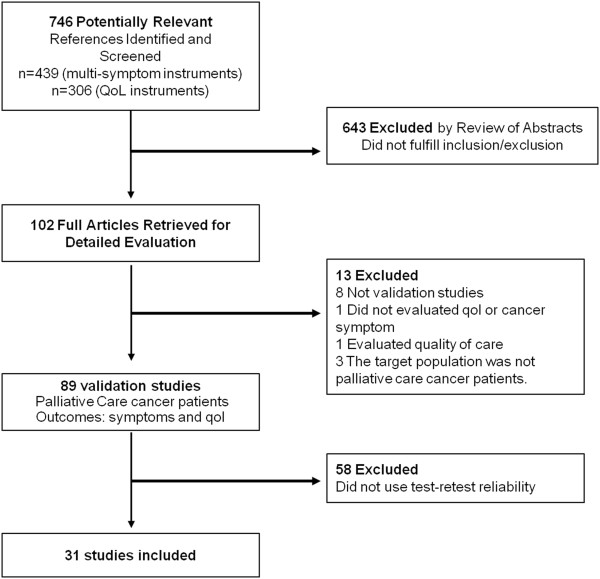
PRISMA flow diagram for search strategy.